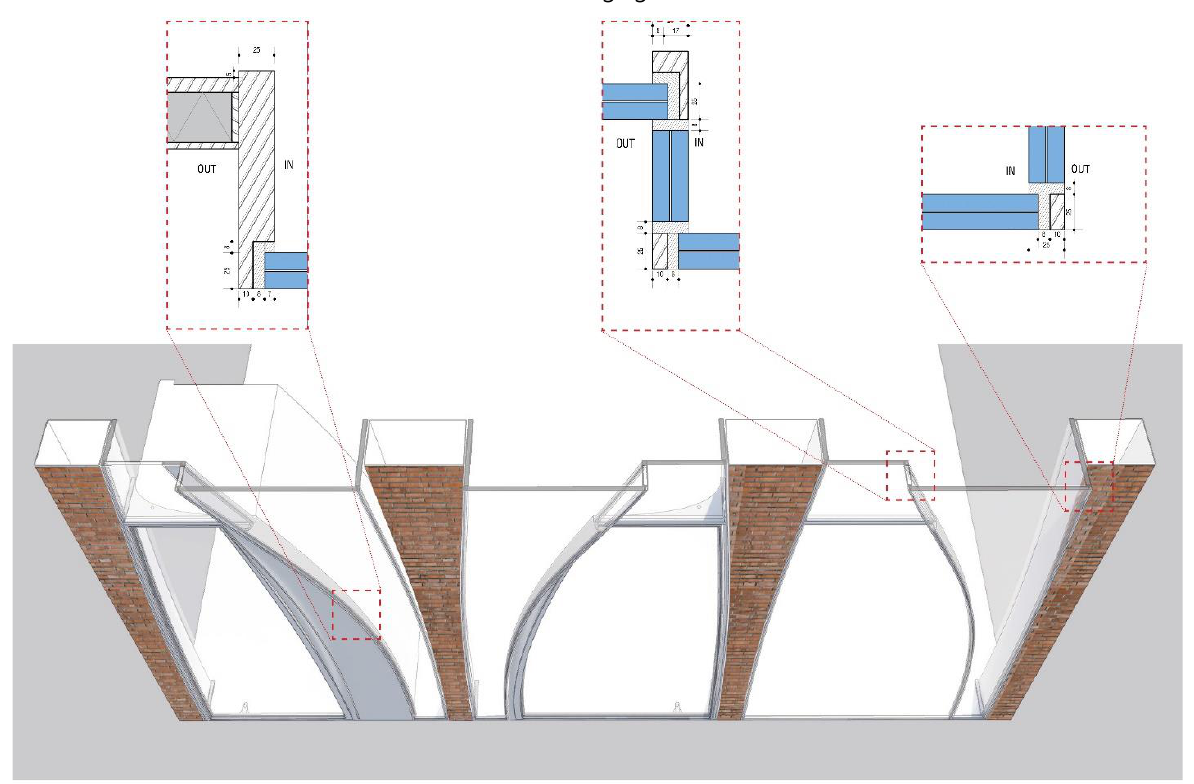
Fig. 4 PC Hooftstraat 138 glass panel fittings. ©